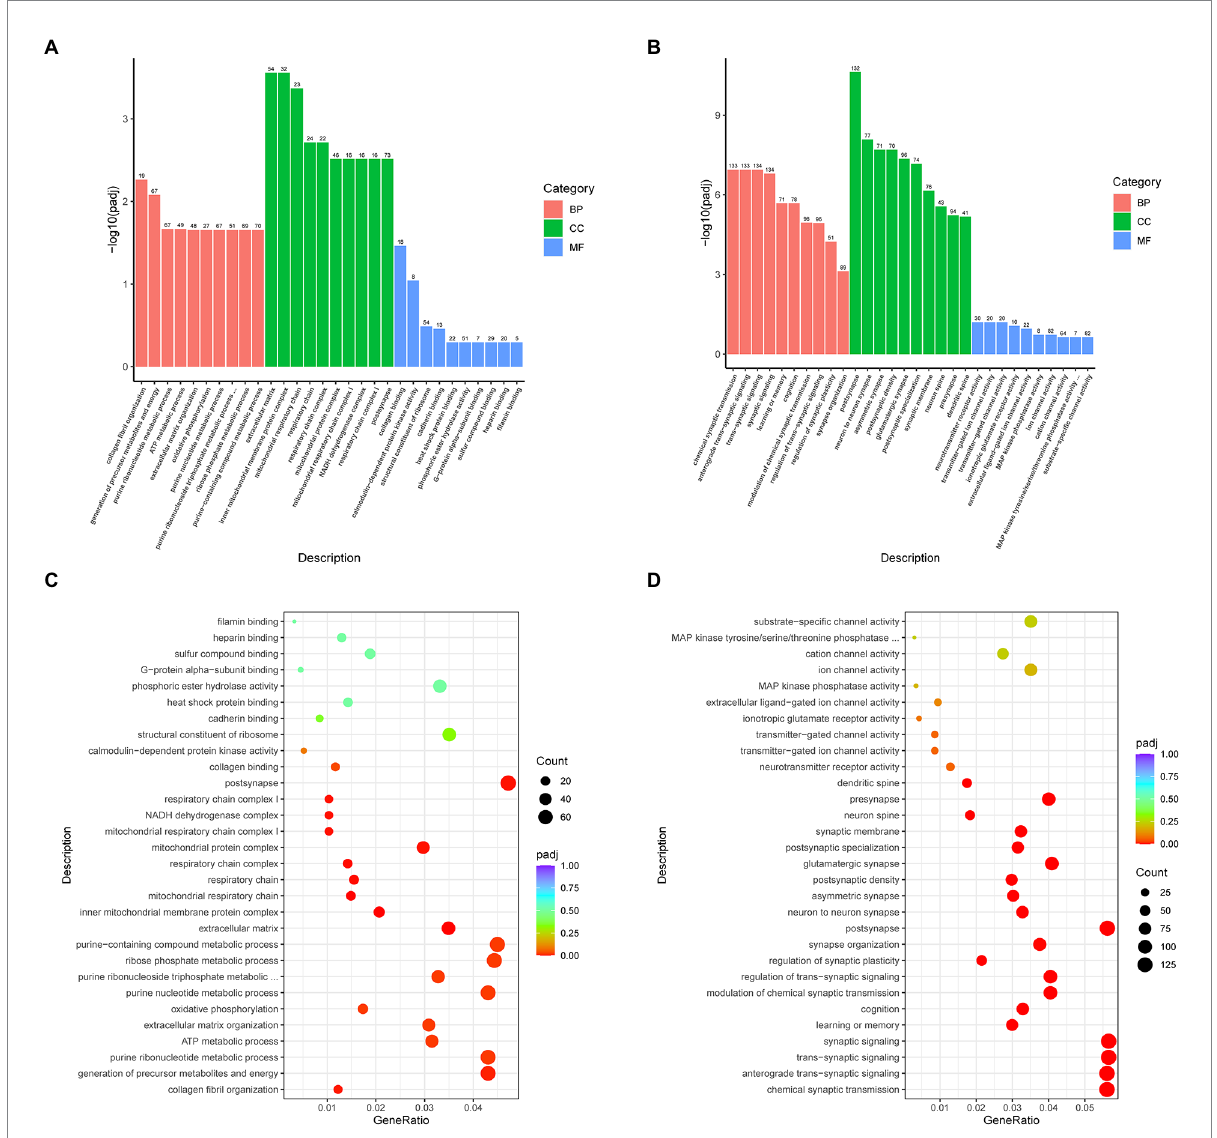
FIGURE 7 Bar charts and dot plots of the main GO term enrichment analysis ( n = 4 per group). Bar chart of the comparison showing the 30 most significant terms between the (A) SMPS and VPA groups and (B) SMPS and C groups (BP, biological process; CC, cell component; and MF, molecular function); and dot plot of the comparison between the (C) SMPS and VPA groups and (D) SMPS and C groups, with every dot representing one pathway. The size and color of each circle represented the gene number in this pathway and p -value,